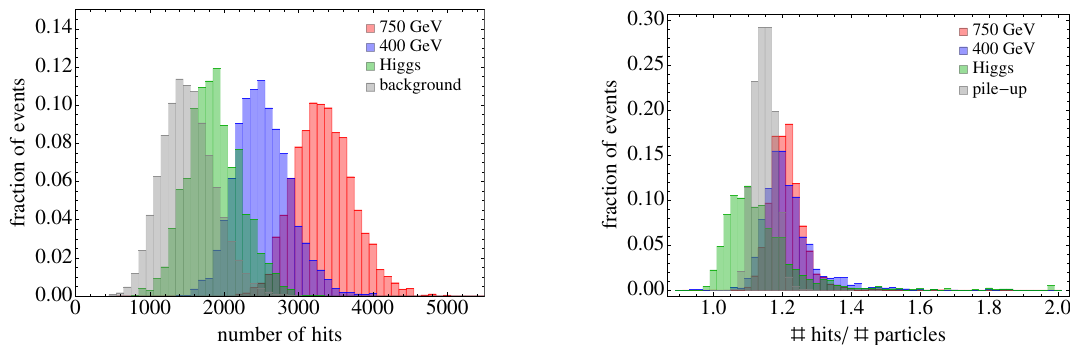
Figure 10. Left: number of hits on the ATLAS IBL for signal and background, both including a pile-up contribution corresponding to h (cid:22) i = 50. Right: ratio of the number of hits on the ATLAS IBL over the number of tracks with j (cid:17) j < 2 : 5. The signal samples do not include pile-up in this